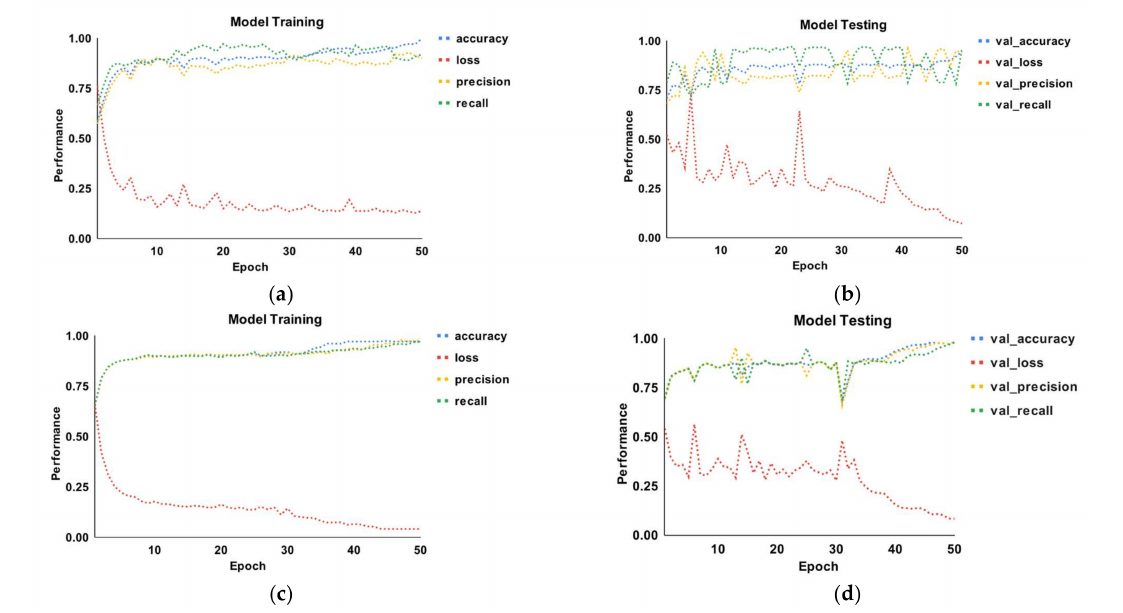
Figure 7. Dynamic epoch curves (accuracy, precision, recall, loss) for malware classification using training and testing data: ( a ) dataset 1 (model training); ( b ) dataset 1 (model testing); ( c ) dataset 2 (model training); ( d ) dataset 2 (model testing).